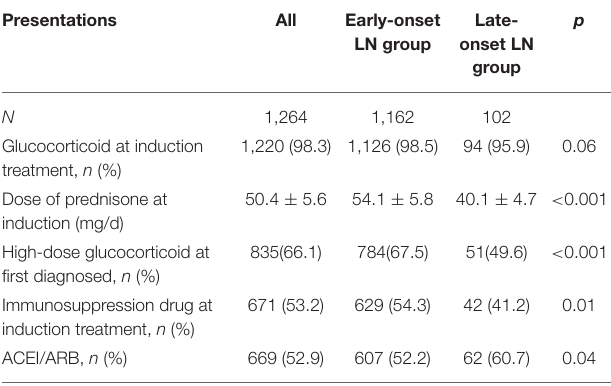
TABLE 3 | Comparisons of treatment regimen between late- and early-onset LN groups.